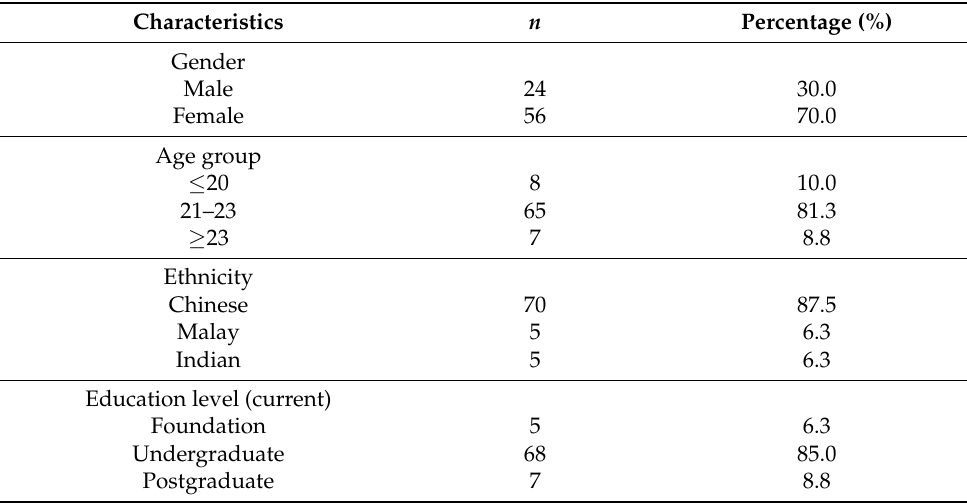
Table 1. Demographic and health status of